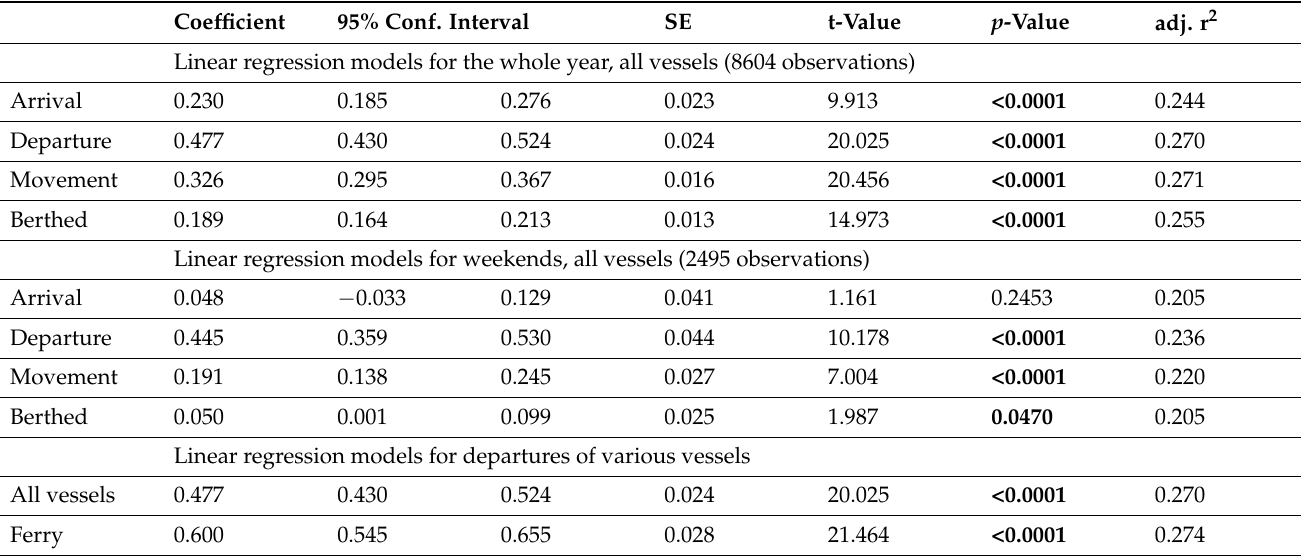
Figure 14. Time variation plot of hourly mean NO 2 concentrations at the Katajanokka terminal in 2021. Table 12. Multivariable linear regression analysis results for vessel arrivals, departures, movement and laying alongside to the logarithm of NO 2 hourly mean concentrations controlled for wind direction, wind speed, relative humidity, air temperature and time of day at the Katajanokka terminal 2021. p -values less than 0.05 in